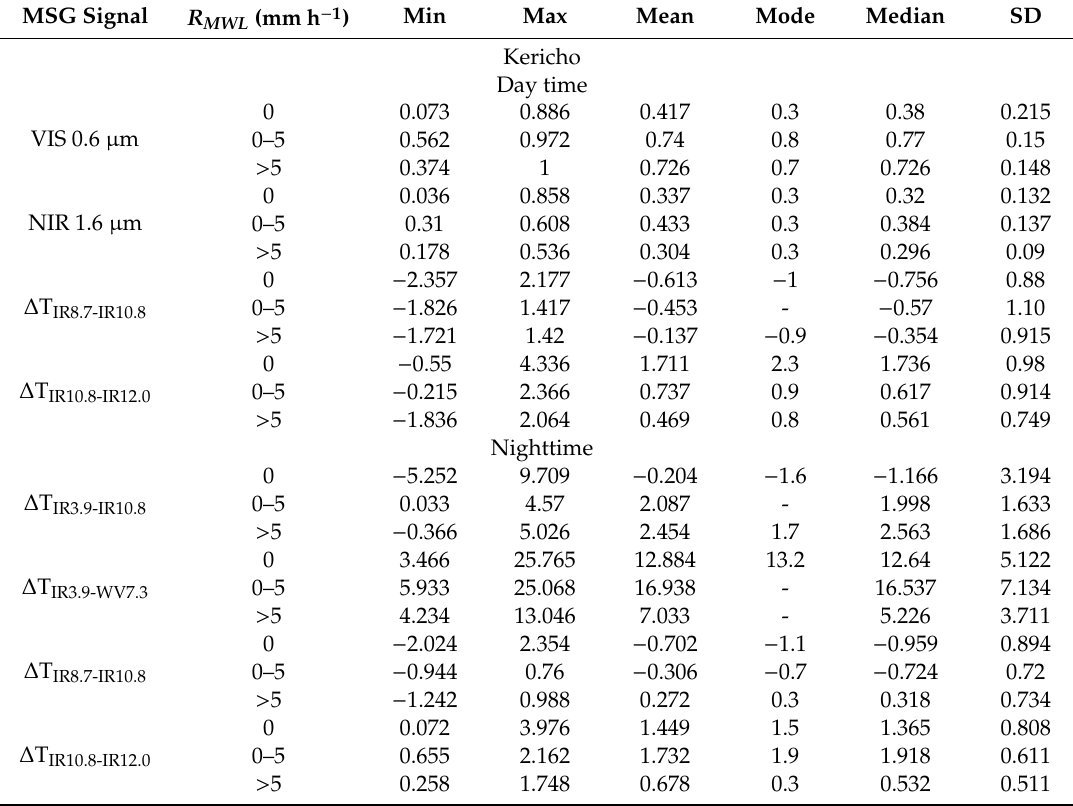
Table A1. Descriptive statistics of SEVIRI satellite signals for each rainfall intensity class and study location. MSG